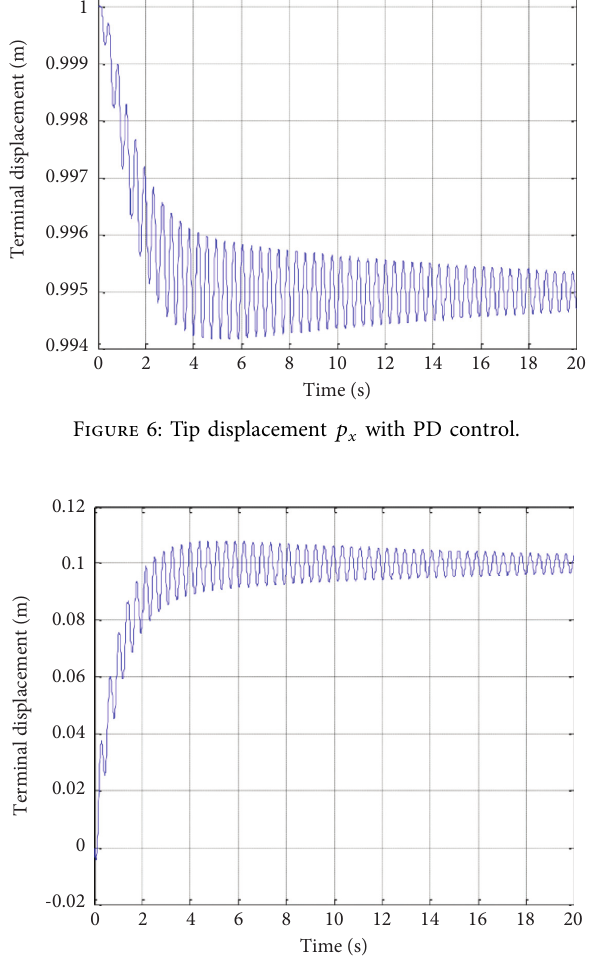
Figure 7: Tip displacement p